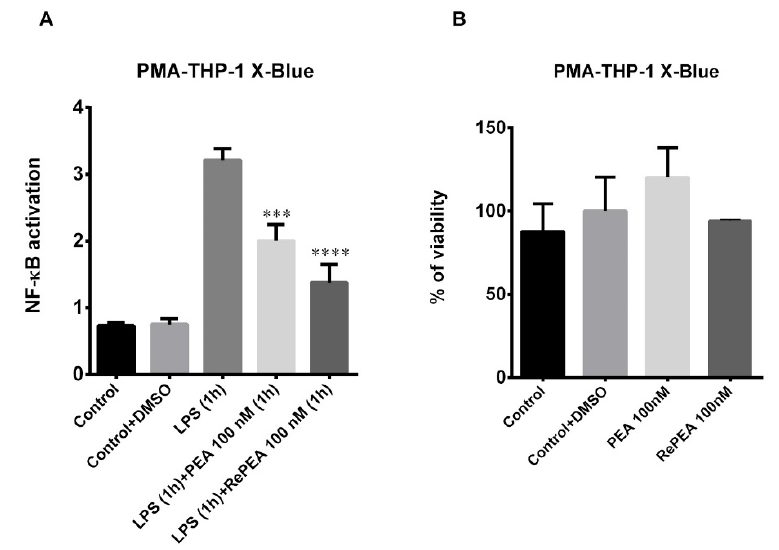
Figure 11. ( A ) Inhibition of NF- κ B activation in LPS-stimulated PMA-THP-1 X-Blue ™ cells by PEA and RePEA. PMA-THP-1 X-Blue ™ cells were stimulated with LPS at 10 ng / mL for 1 h; then, the LPS-containing medium was removed and cells were incubated for 1 h with 100 nM PEA and RePEA. Then, the medium was replaced with fresh RPMI. The amount of SEAP (secreted embryonic alkaline phosphatase) released into the culture medium was quantified after 24 h as a measure of NF- κ B activation. Data are presented as mean ± S.E.M. ( n = 3 independent experiments), normalized on MTT data (the activity of SEAP, expressed as OD, was normalized on the MTT OD value of each corresponding well, as a measure of cell viability). Significant di ff erences from LPS were determined using nonparametric one-way analysis of variance (ANOVA) with post hoc Dunnett’s multiple comparison tests at *** p < 0.001, **** p < 0.0001. ( B ). Cell viability in PMA-THP-1 X-Blue ™ cells incubated for 1 h with 100 nM PEA and RePEA. Then, medium was replaced with fresh RPMI. Cell viability was quantified after 24 h. Data are presented as mean ± S.E.M. ( n = 3 independent